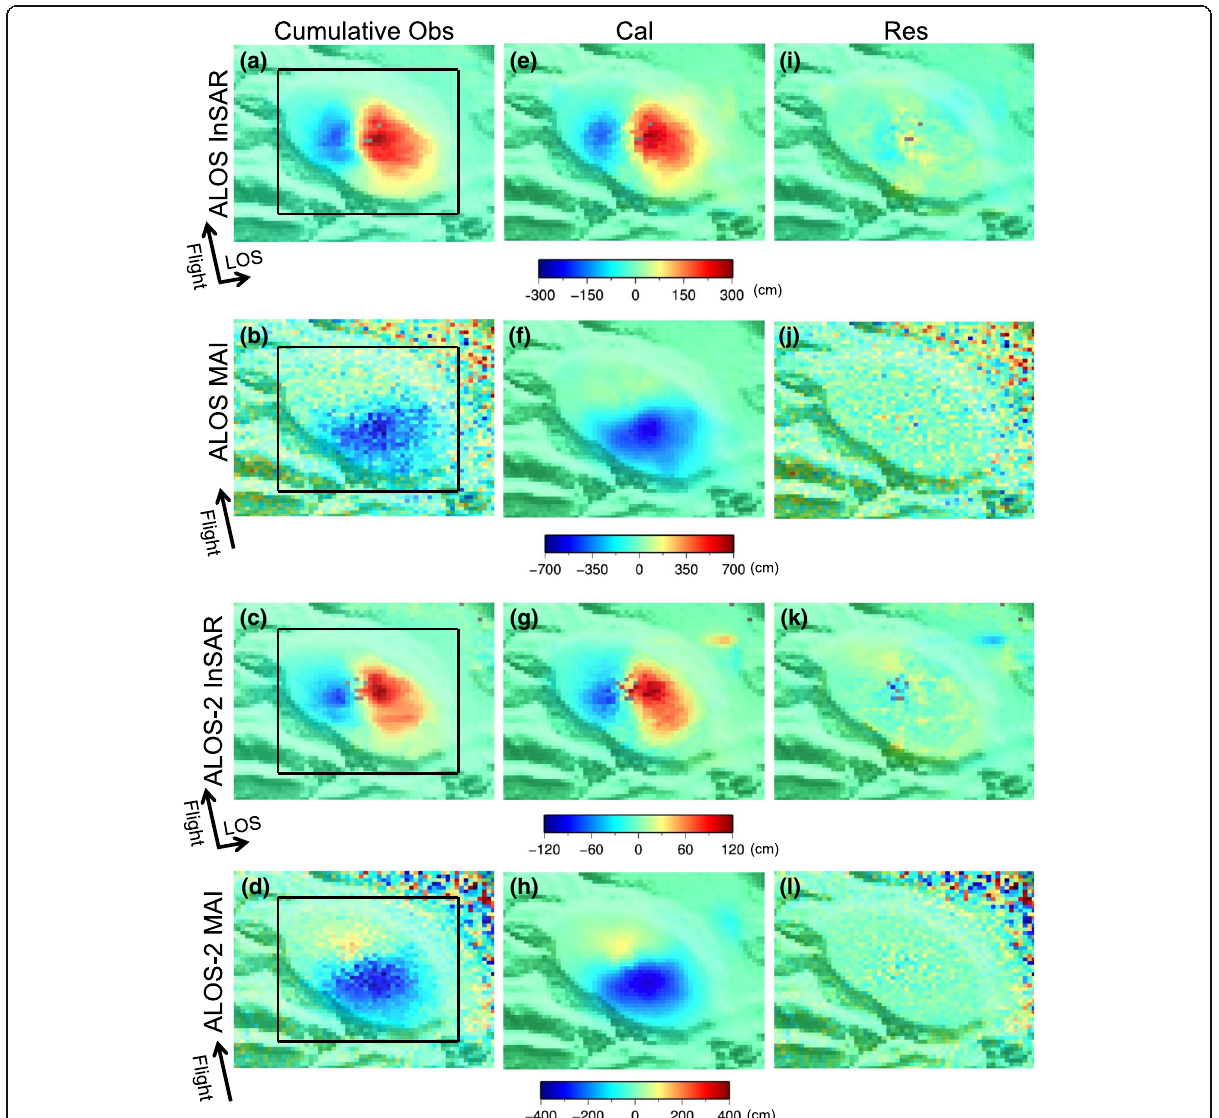
Fig. 11 Comparisons of cumulative observed data, calculated data, and the misfit residual. The left column ( a – d ) is the observed cumulative InSAR and MAI data, the middle one ( e – h ) is the calculated InSAR and MAI data derived from the source model in Figs. 12 and 13, and the right column ( i – l ) is the misfit between the observation and the calculation. The plan view of the source model in Figs. 11 and 12 is indicated with a black